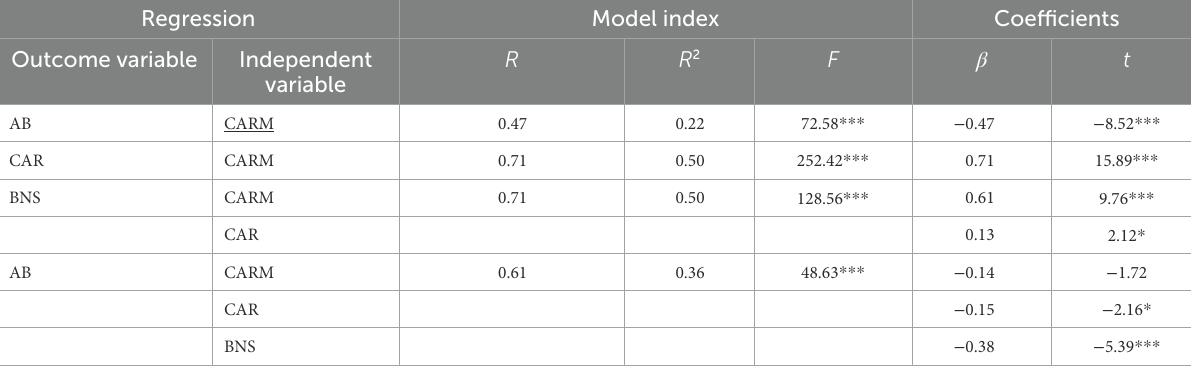
TABLE 2 Regression analysis of variables in the